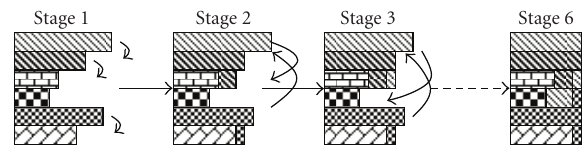
Figure 3: EREC bit reorganization